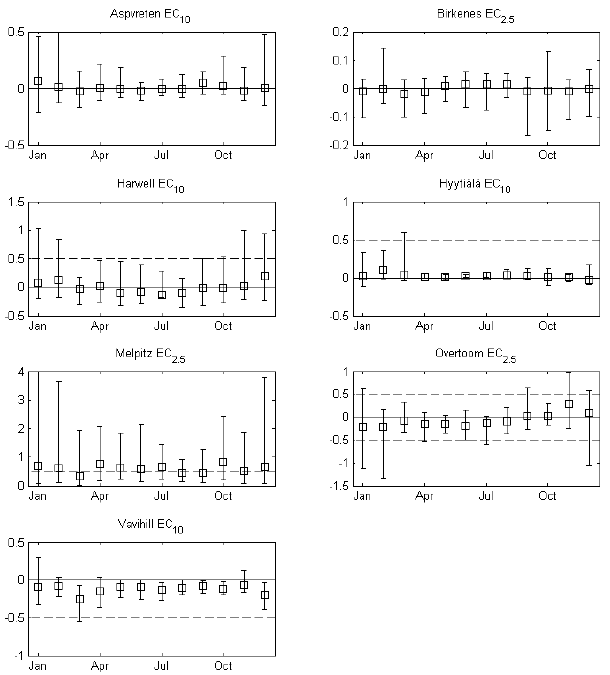
Fig. 5. The seasonal variation of the difference between measured and modelled EC (standard model setup, STD). Boxes show the medians of measured EC − model EC for each month. Error bars represent 10th and 90th percentiles. Dashed lines =± 0.5µgm − 3 . Note that the error bar for Melpitz (January) ends outside the y axis scale (90th percentile = 6.75). Unit: µgm − 3 .